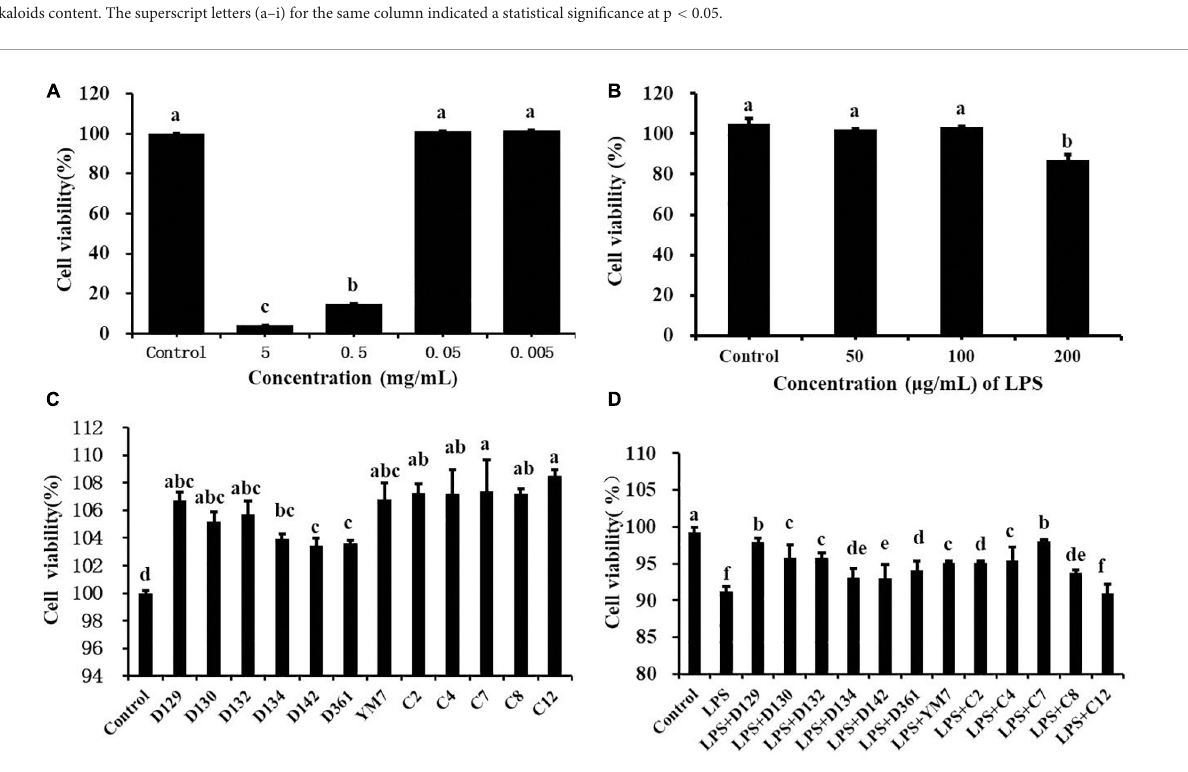
FIGURE1 The cytotoxicity effect of hemp leaf extracts on MDCK cells. (A) The cytotoxicity of Ym7 hemp leaf extract on MDCK cells. (B) Dose-response effect of LPS in causing inflammatory damage to MDCK cells. (C) The effect of 12 hemp leaf extracts (50 µ g/mL) on the proliferation of MDCK cells. (D) The protective effect of hemp leaf extracts (50 µ g/mL) against LPS-induced inflammatory damage in MDCK cells. The superscript letters (a–f) indicated a statistical significance at p < 0.05.